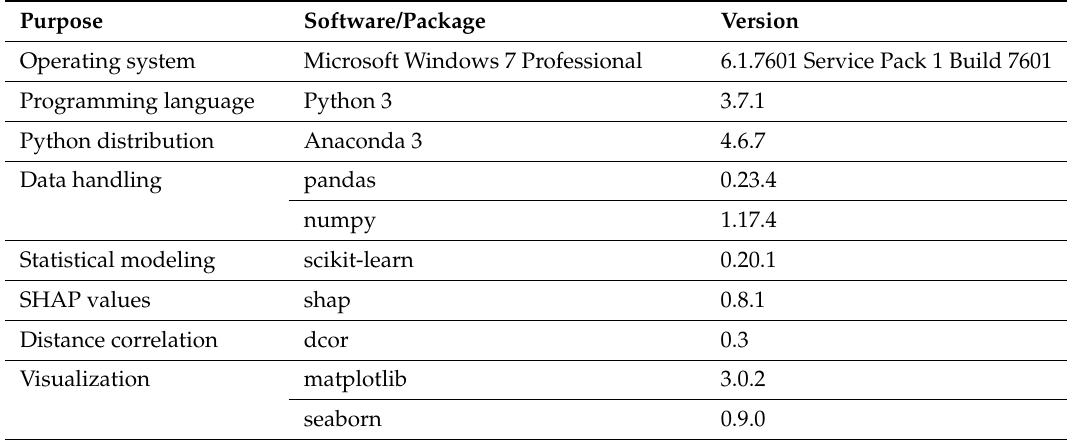
Table A2. Software specifications for the numerical